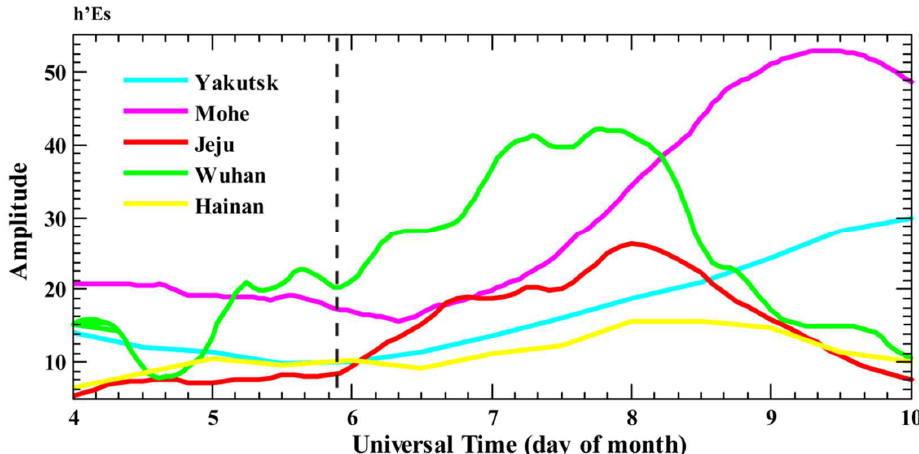
Figure 5. The spectrum of h’Es calculated by Lomb-Scargle analysis for the period of 12 h at different stations from 4 to 10 July 2013. The black dash line indicates the onset of the storm.